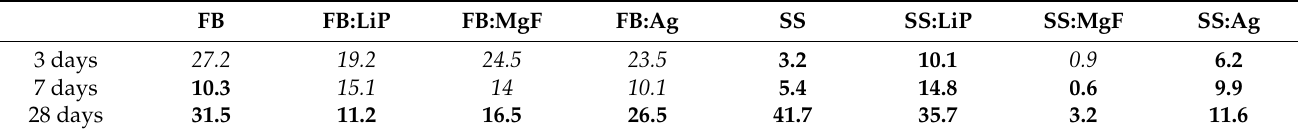
Table 3. The mass losses (in italics ) and gains (in bold ) obtained for simple and doped FB and SS thin films after immersion in DMEM-FBS for 3, 7, and 28 days. The values were calculated as percentages (%) from the initially deposited film masses (before immersion in